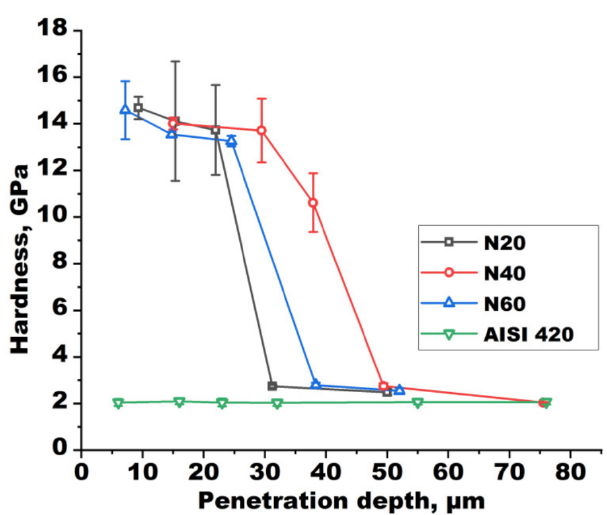
Figure 8. The hardness distributions of the cross-sections of the samples over a sample depth. Table 1. The thickness of the CL and DZ layers and wear characteristics of the samples.